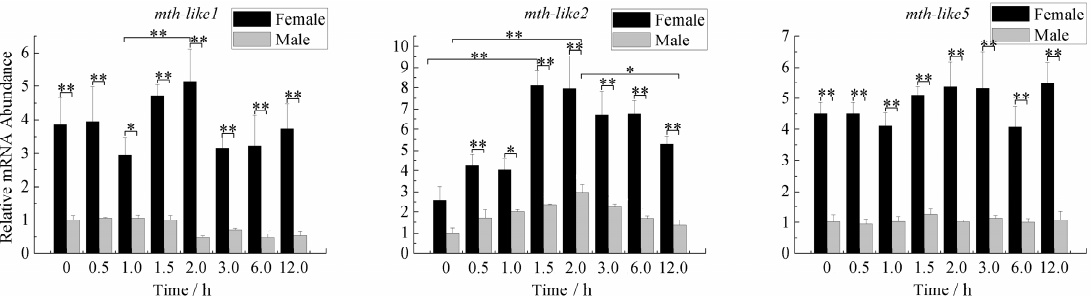
Figure 7. Expression profiles under the stress of high temperature. The relative expression indicates the level of each mth-like transcript normalized to the internal standard of α –tubulin, compared to the expression level of the first group (0 h). 0–12 h means different time of adults exposed at a high temperature of 45 ◦ C. Data are shown as the mean ± SD. Asterisks indicate differences that are statistically significant (*, p < 0.05; **, p < 0.01).